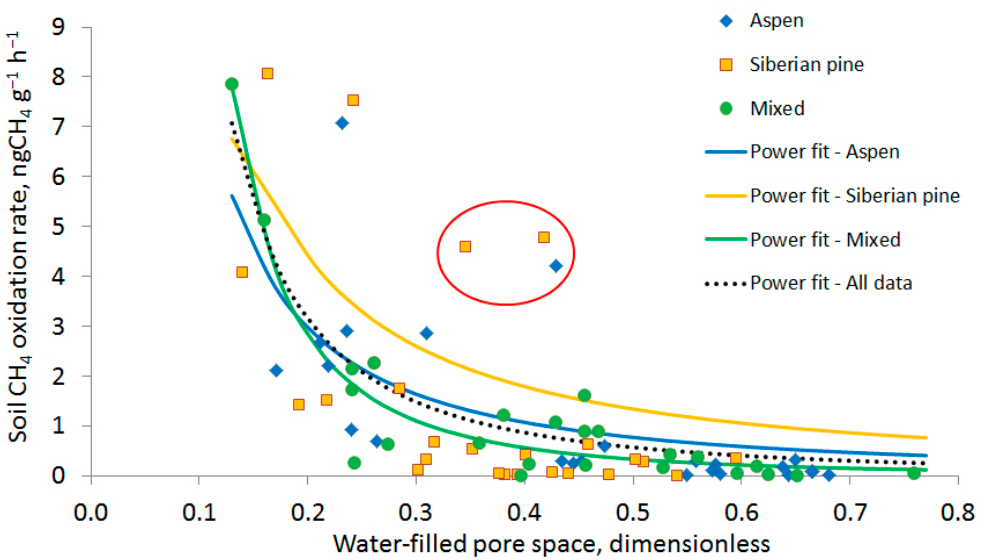
Figure 3. Power models fitted for soil CH 4 oxidation rate versus water-filled pore space for all data and for each forest type separately. Outliers are denoted by red ellipse.